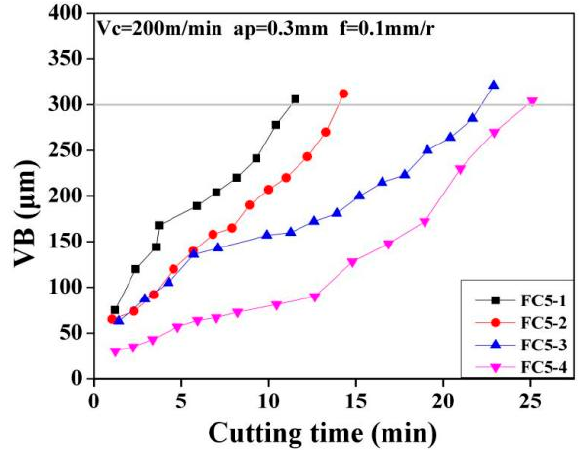
Figure 11. The flank wear VB vs. cutting time for WC-Co-Zr.